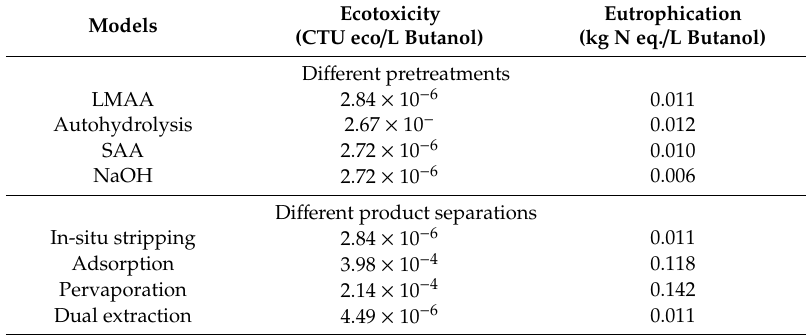
Table 9. Ecotoxicity and eutrophication potentials of simulated cellulosic butanol production